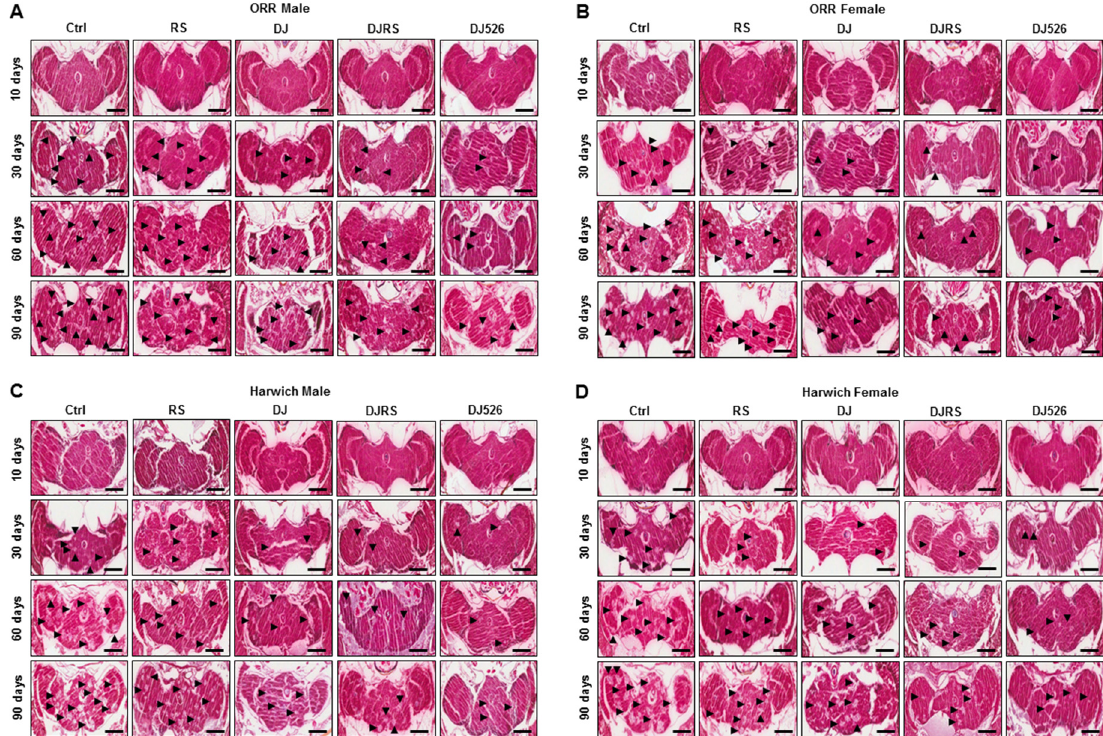
Figure 5. The resveratrol rice DJ526 inhibited age-related neurodegeneration in D. melanogaster . ( A ) ORR males, ( B ) ORR females, ( C ) Harwich males and ( D ) Harwich females. Ctrl represents standard cornmeal medium; RS represents cornmeal medium supplemented with resveratrol at 31.54 µ g / L, the equivalent amount of resveratrol found in the DJ526 media; DJ represents the medium in which 50% of cornmeal was replaced with Dongjin rice; DJRS represents the medium in which 50% of cornmeal was replaced with Dongjin rice and supplemented with resveratrol at 31.54 µ g / L, and DJ526 represents the medium in which 50% of the cornmeal was replaced with the resveratrol rice DJ526 (Table S1). A histological analysis was performed by H&E staining to examine the neurodegeneration of the Drosophila brains at the 10th, 30th, 60th and 90th days post-eclosion. n = 100; scale bars: 200 µ m. The vacuolar lesions are indicated as black triangles.